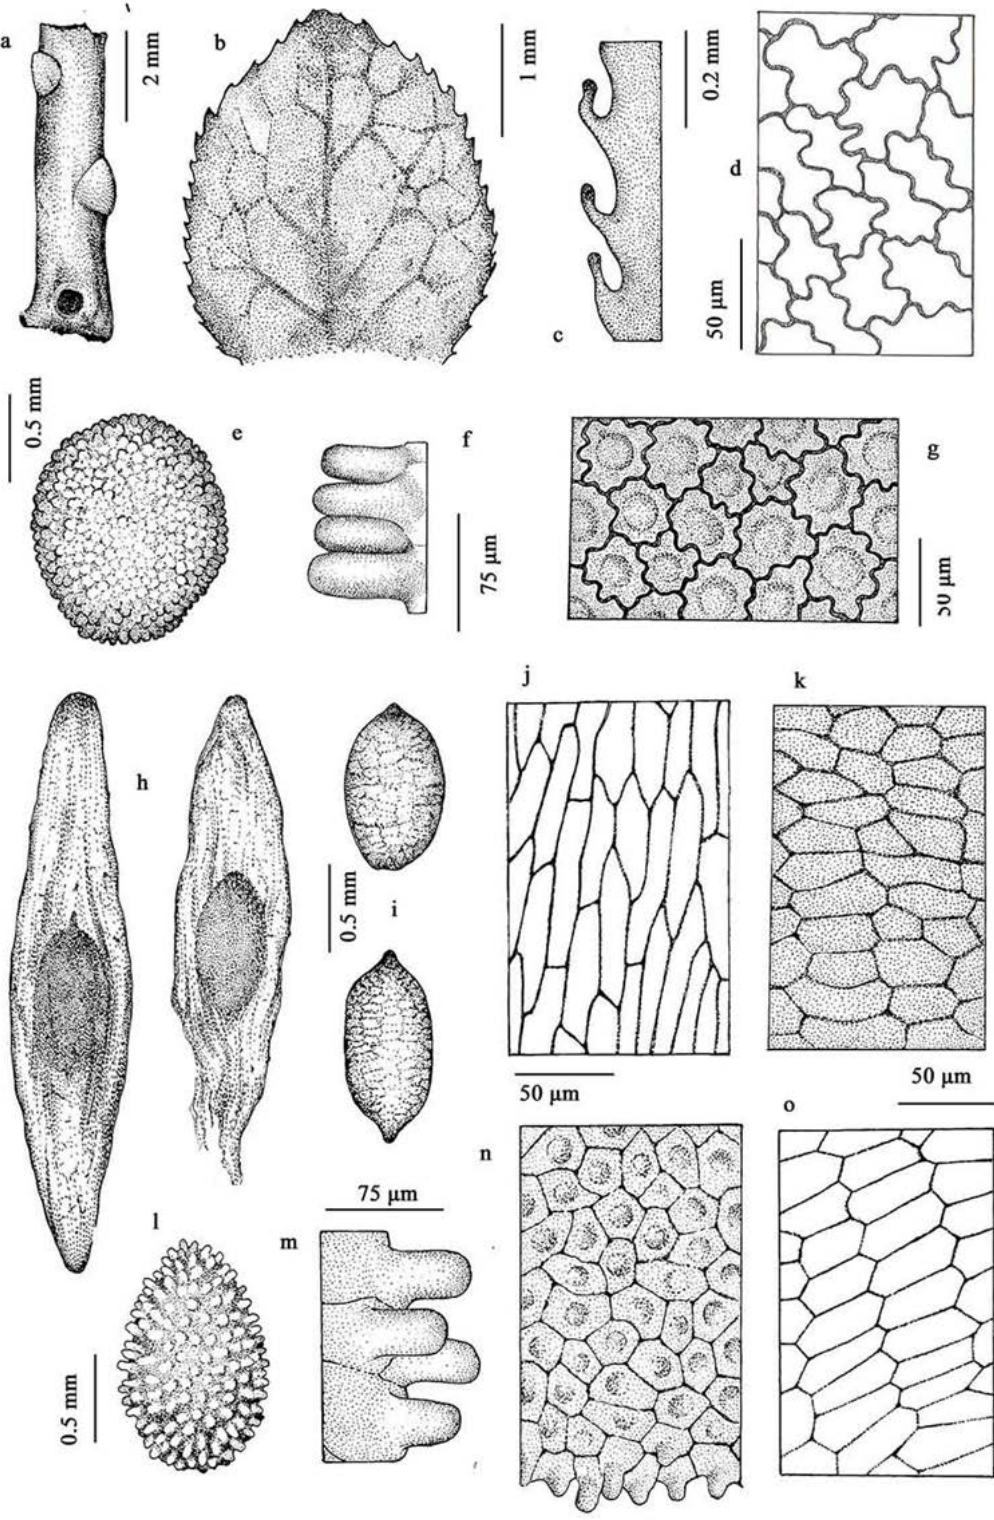
Figure A6. Vaccinium myrtillus : a) fragment of twig with alternate buds; b) leaf blade; c) serrulate leaf margin with remains of glandular hairs; d) epidermal cells of adaxial leaf blade. Daboecia cantábrica : e) seed; f) testa fragment with baculiform ornamentation; g) seed testa epidermal cells. Drosera rotundifolia : h) seeds with testa; i) seed s without testa (the outer cover is tegmen); j) testa epidermal cells; k) tegmen epidermal cells. Drosera intermedia : l) seed; m) testa fragment with baculiform ornamentation; n) testa epidermal cells; o) tegmen epidermal